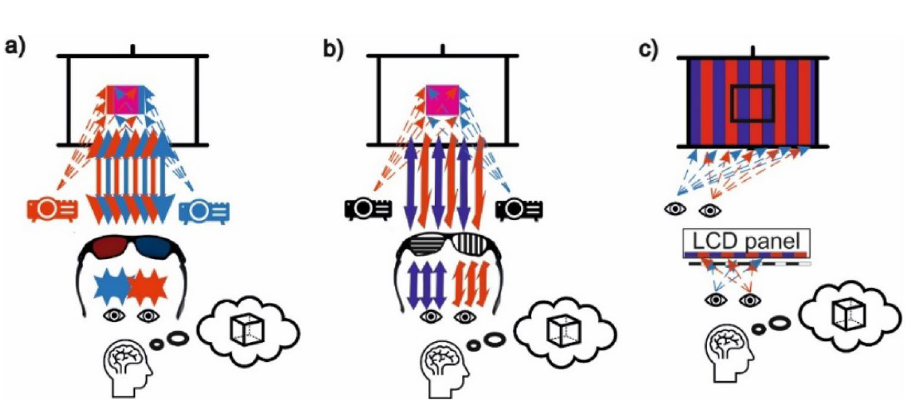
Figure 1. Components of a holographic pyramid ( a ) and the principle of virtual image formation in a plane mirror ( b ). Source own study.